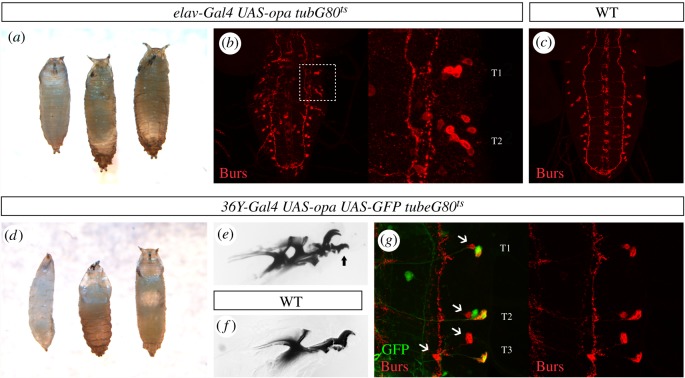
Opa activates Burs expression in no-CCAP neurons. (a) Ectopic expression of opa under the control of elav-Gal4 leads to early pupal lethality. (b) Larval CNS of the previous genotype showing an ectopic activation of Burs in a large number of neurons, especially in lateral neurons of the thoracic VNC. (c) Wild-type expression of Burs in the VNC of an L3 larva. At this stage, hemineuromeres T1 and T2 express Burs in one neuron and hemineuromeres T3-A7 express Burs in two cells. (d) Ectopic expression of opa under the control of 36Y-Gal4 also leads to early pupal lethality. (e) Larvae of a similar genotype showing that the L2 mouth parts (arrow) do not detach from the L3 mouth hooks. (f) Wild-type mouth hooks. (g) Ectopic Burs activation can be observed in a subset of 36Y-Gal4 UAS-opa expressing cells in the lateral VNC. The arrowheads indicate the endogenous expression of Burs. (b,c,g) correspond to the maximum projection of stacks.